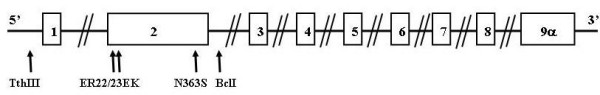
Positioning of the glucocorticoid receptor gene polymorphisms studied in the cystic fibrosis patients.